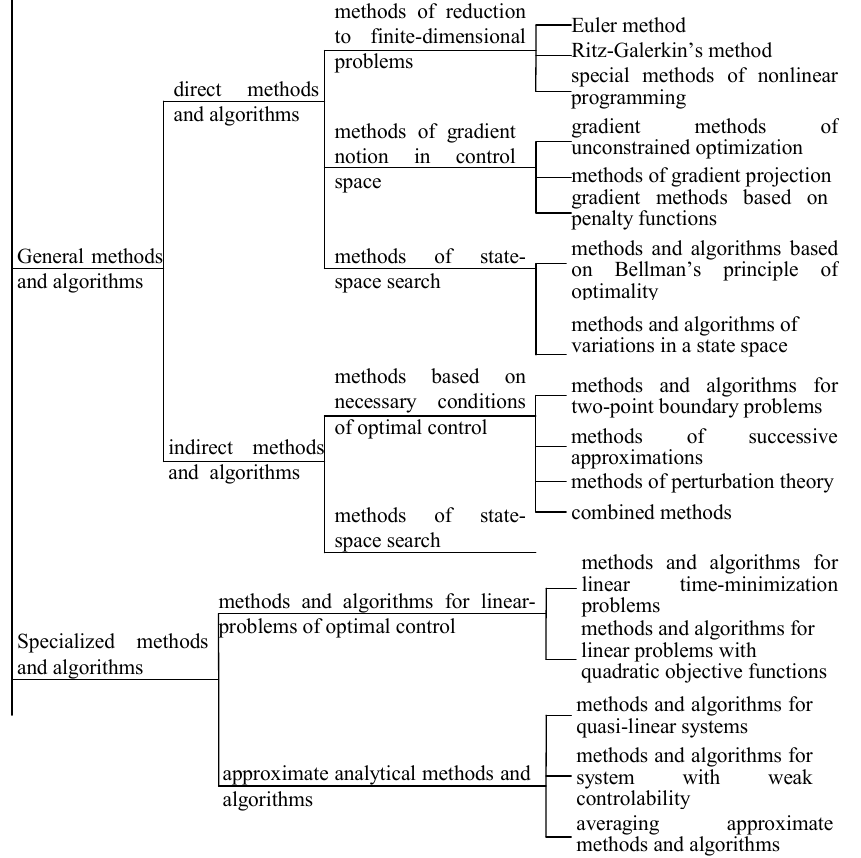
Figure 2. Optimal control computational methods.